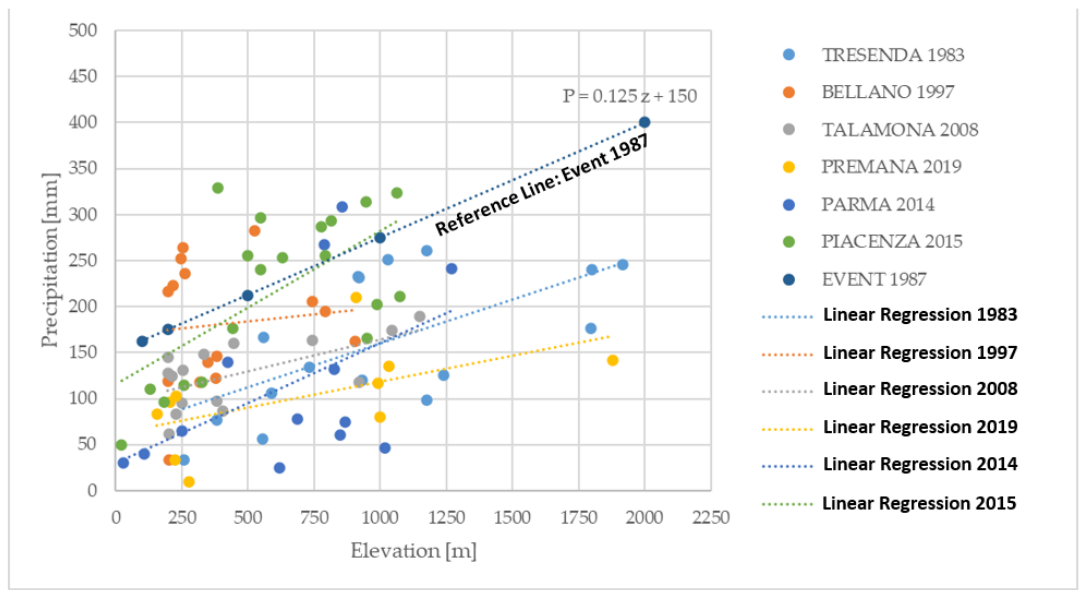
Figure 7. For each event examined, the linear regression between elevation and precipitation was calculated. Table 5 shows the parameters and the low scores of this regression through the R 2 index. However, the angular coefficients of the line follow approximately the reference line produced for the 1987 event recorded across the Southern Alps area in the Lombardy